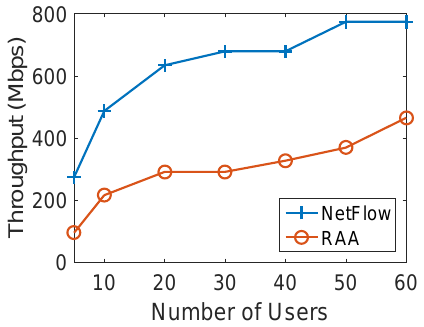
Figure 7. Throughput for varied numbers of users with 10